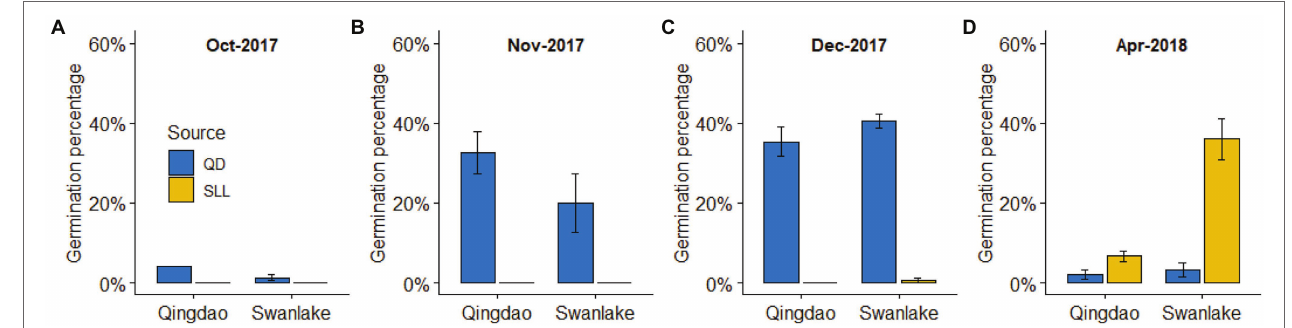
FIGURE 2 | Germination percentages (means ± SE) of eelgrass seeds in a reciprocal transplant experiment at Qingdao Bay (QB) and Swan Lake (SL). (A-D) represent different observation time.